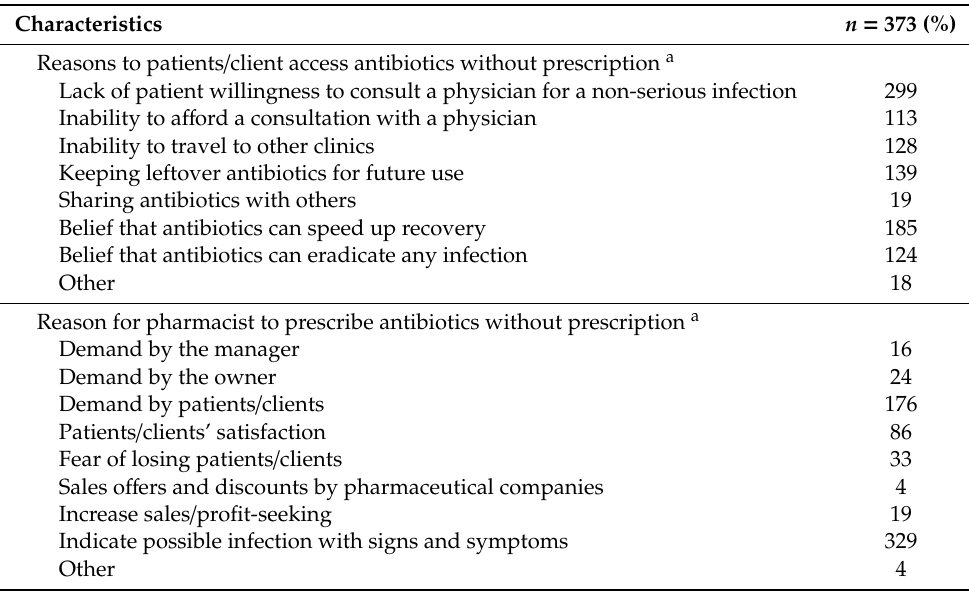
Table 6. Reasons of using antibiotics without prescription.